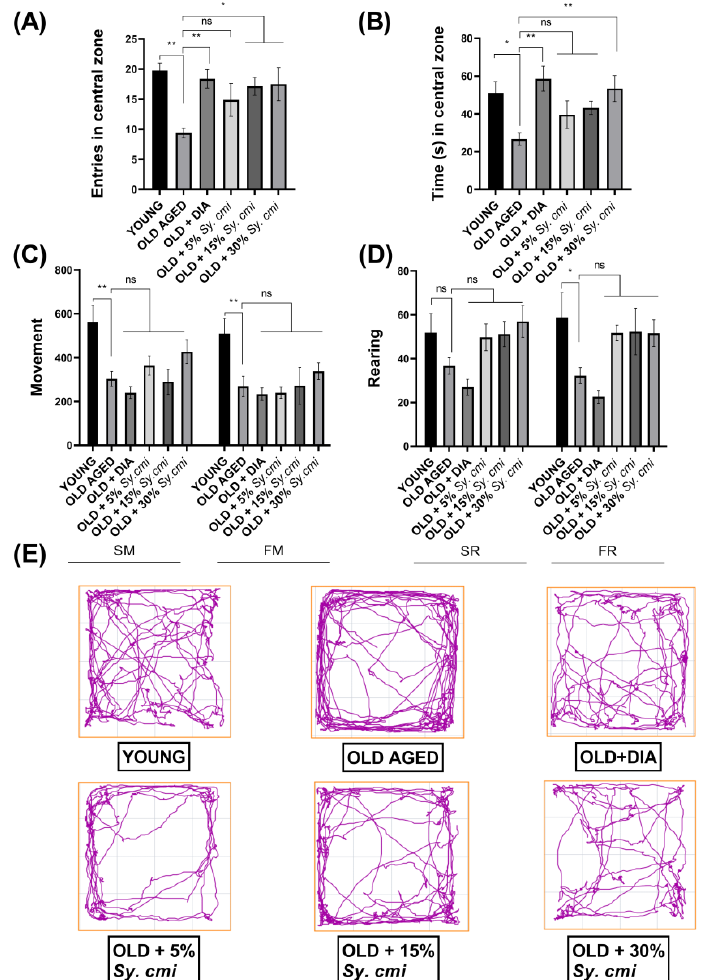
Figure 3. The mice ( n = 8) supplemented with 5, 15, and 30% dilutions of Sy. cmi for 16 months were allowed to explore the square-shaped arena for 5 min to evaluate anxiety-like behavior by noticing their ( A ) entries in central zone, and ( B ) time in central zone. Further, the mice were examined for their horizontal and vertical locomotor activity and outcomes were expressed as ( C ) movements, ( D ) rearing, and ( E ) track plots of animal activity in open field. The outcomes of all groups were compared with the aged control group and * p < 0.05, ** p < 0.01 were considered statistically signif- icant while ns showed non-sgnificant outcomes for all data presented as mean ± SEM. As two of the behaviors involved in locomotion are exploring and walking in open field activity, the mice have also been observed for their vertical and horizontal locomo- tion in terms of the number of slow and fast rearing and movements. A marked decrease in horizontal movements is noted in old-aged mice as compared to young animals for slow movements ( p = 0.003) and fast movements ( p = 0.007), and older mice prefer to sit in the outer corners of the maze with less exploration of the center. Likewise, fast rearing is decreased in geriatric mice ( p = 0.025) as compared to young animals. However, the impact of Sy. cmi supplementation does not reverse the age-related decline in locomotor activity in mice, as the difference for movements and rearing remains non-significant ( p > 0.05) in Sy. cmi treated groups as compared to older untreated mice (Figure 3C,D).